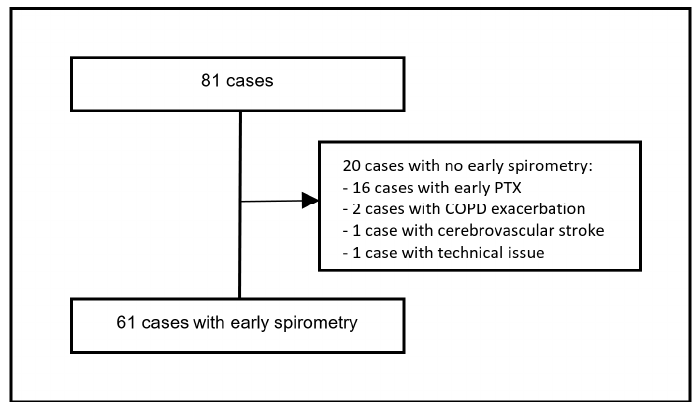
Figure 2. Cases flow chart ( n = 81 cases total, n = 61 with early spirometry). Table 2. Post-interventional pneumothorax ( n = 16).